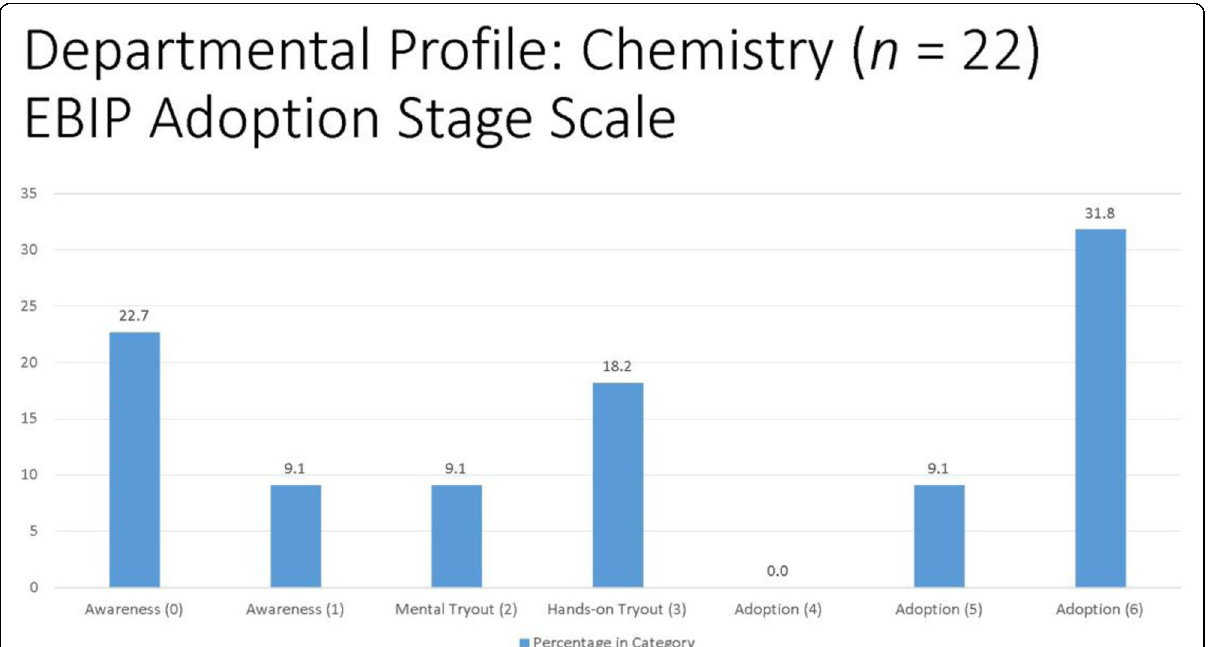
Fig. 2 Departmental Profiles Based on EBIP Adoption Stage Scale